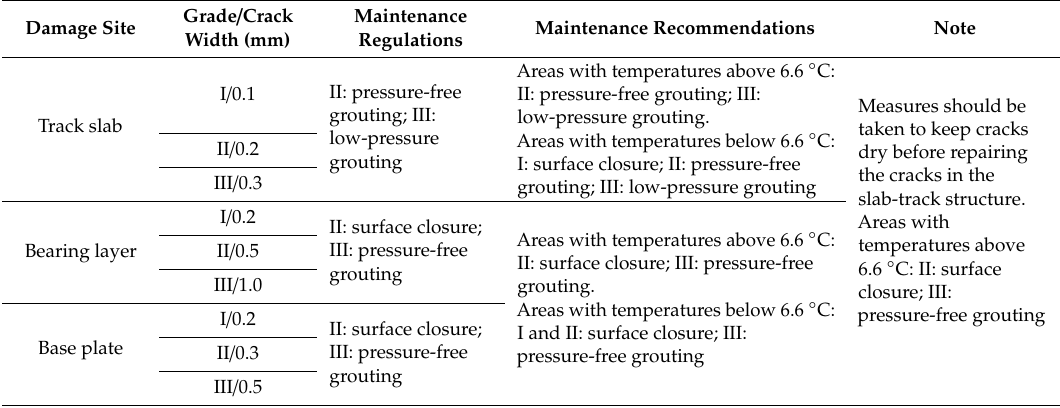
Table 4. Slab-track bed damage grade and maintenance